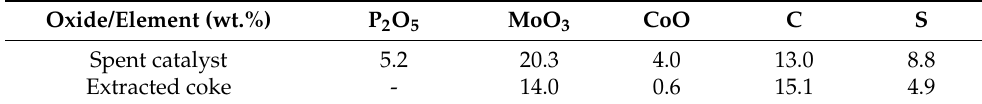
Table 1. Composition of the spent catalyst and extracted coke. Oxide/Element (wt.%)